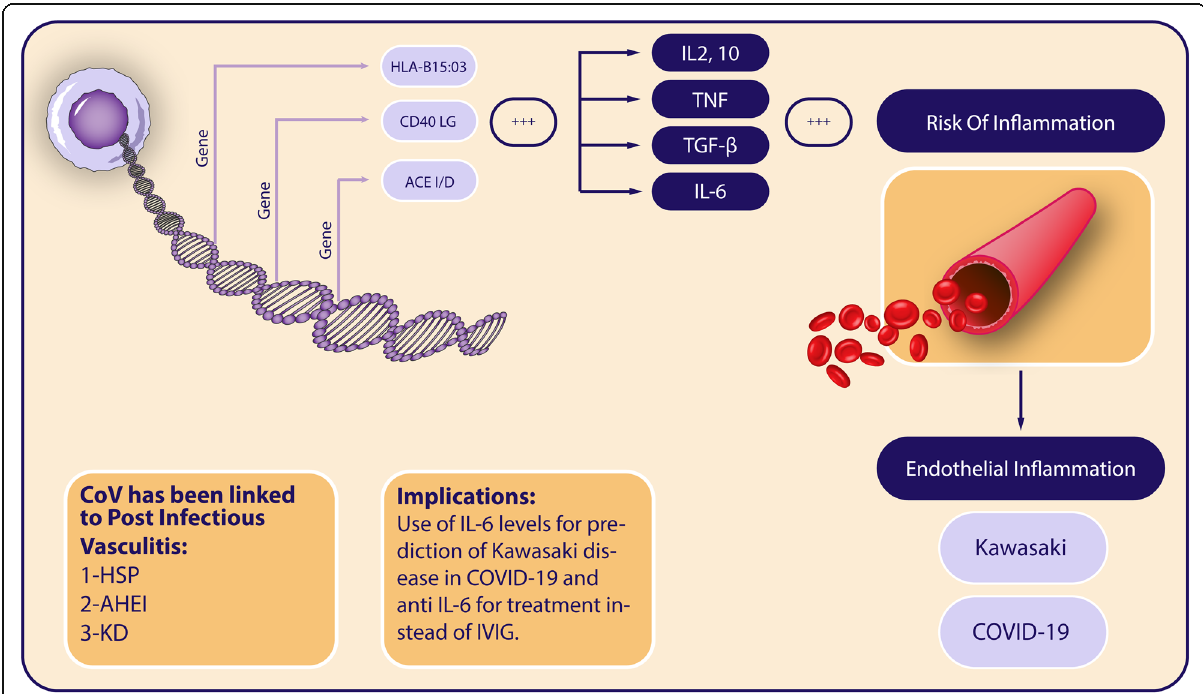
Fig. 1 Summary of possible linkage pathways between Kawasaki disease and COVID-19. HLA, human leukocyte antigen; CD4, cluster of differentiation 4; ACE, angiotensin-converting enzyme; IL, interleukin; TNF, tumor necrosis factor; TGF-beta, transforming growth factor beta; HSP, Henoch-Schonlein purpura; AHEI, acute hemorrhagic edema of infancy; KD, Kawasaki disease; IVIG, intravenous